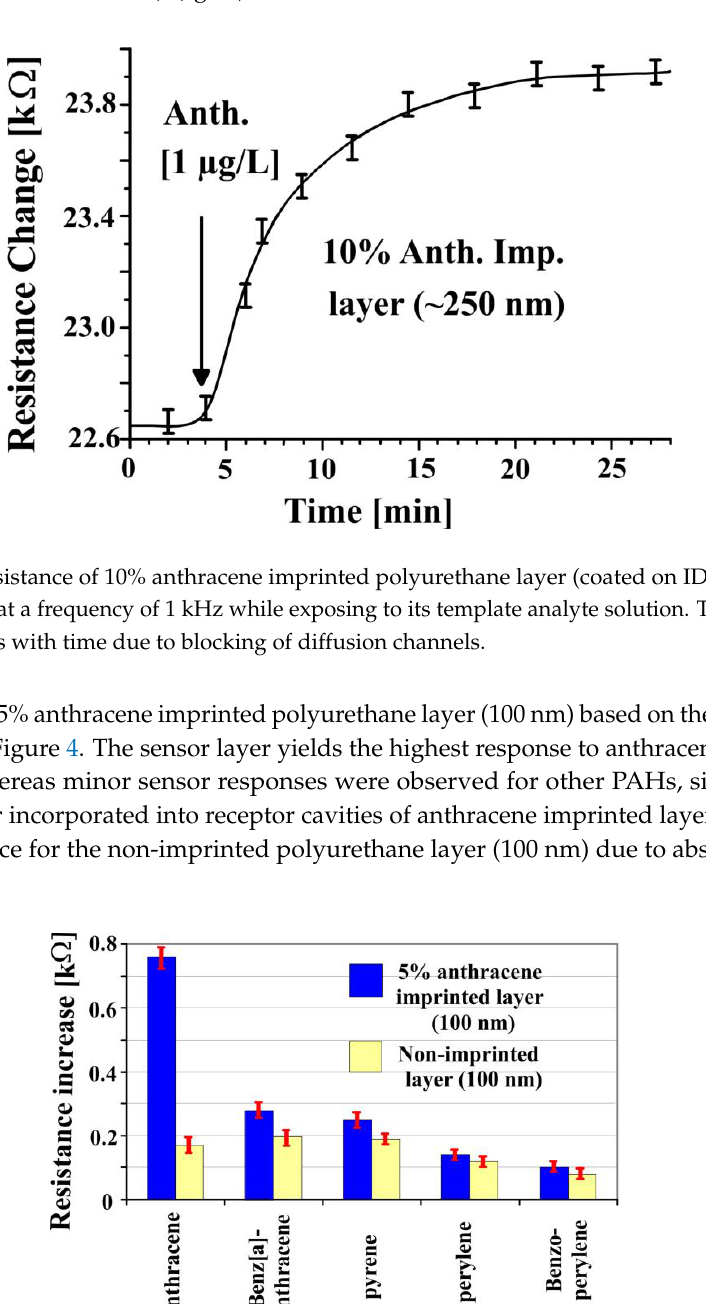
Figure 4. Anthracene imprinted layer was exposed to its templated analyte as well as other PAHs. The sensor showed higher sensor response to its templated analyte, but fewer responses were observed for other PAHs.